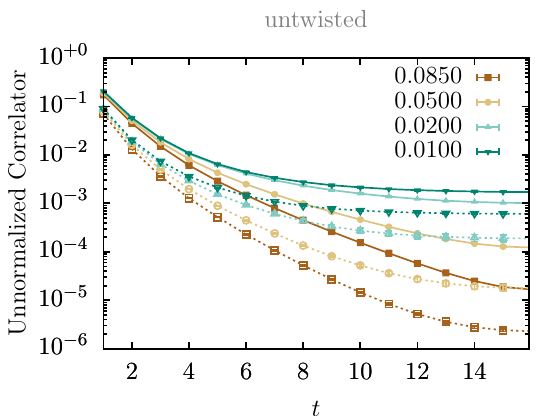
Figure 18 . Correlators for our four mass parameters at β = 5.0 from untwisted simulations on the 16 3 × 32 lattice without normalization, see top four rows of table 7(b). Solid/dotted lines with filled/open markers connect the data points of a- π resp. a- a to guide the eye. The labels indicate the distance | m − m crit | to the critical point. Errors are mostly smaller than the marker